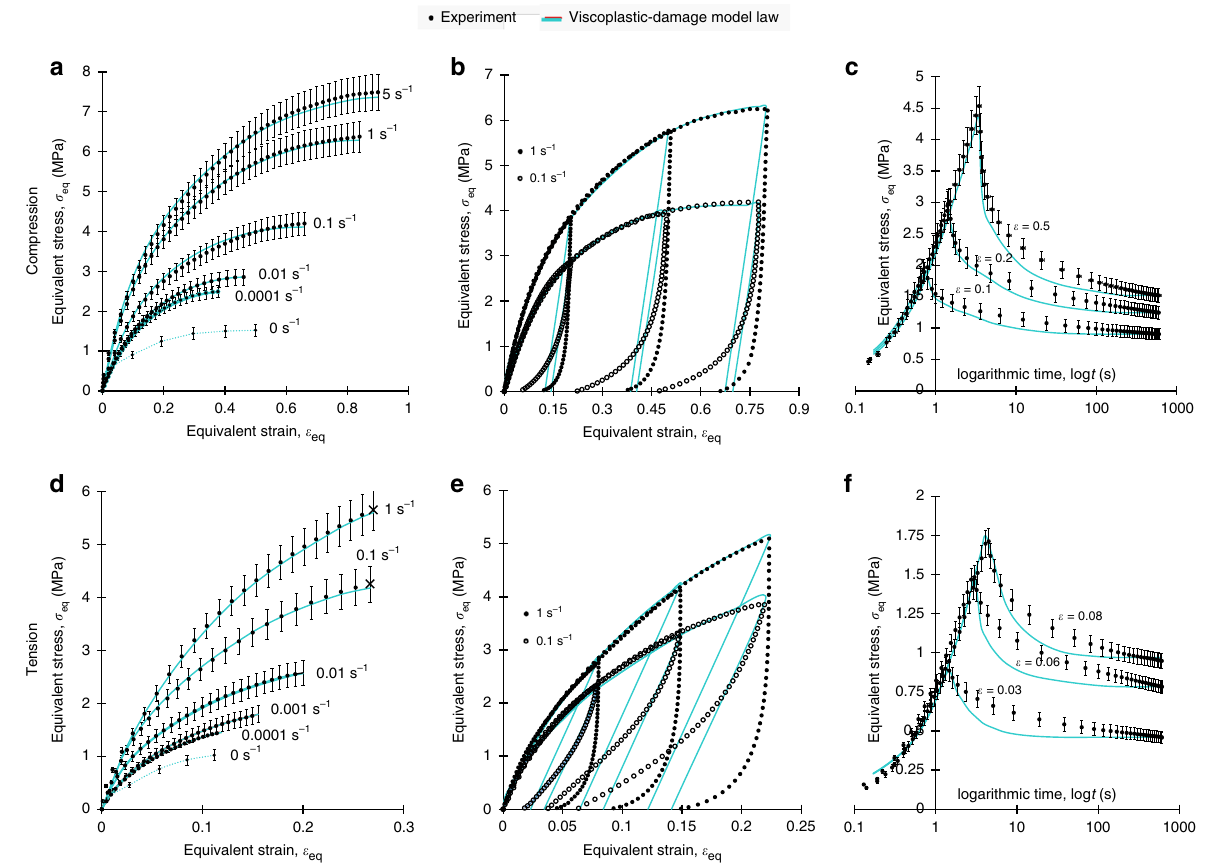
Fig. 2 Equivalent stress versus equivalent strain data together with the viscoplastic-damage law fi t. a depicts monotonic compression, b loading-unloading in compression, c relaxation in compression, d monotonic tension, e loading-unloading in tension, f relaxation in tension. Error bars denote percentage experimental error. The ‘ x ’ marker of last data points in monotonic tensile curves denotes ultimate specimen failure. The data for 0 s − 1 strain rate in a , d correspond to the last data points (long term stresses) in c , f respectively. The viscoplasticdamage law is implemented in ABAQUS